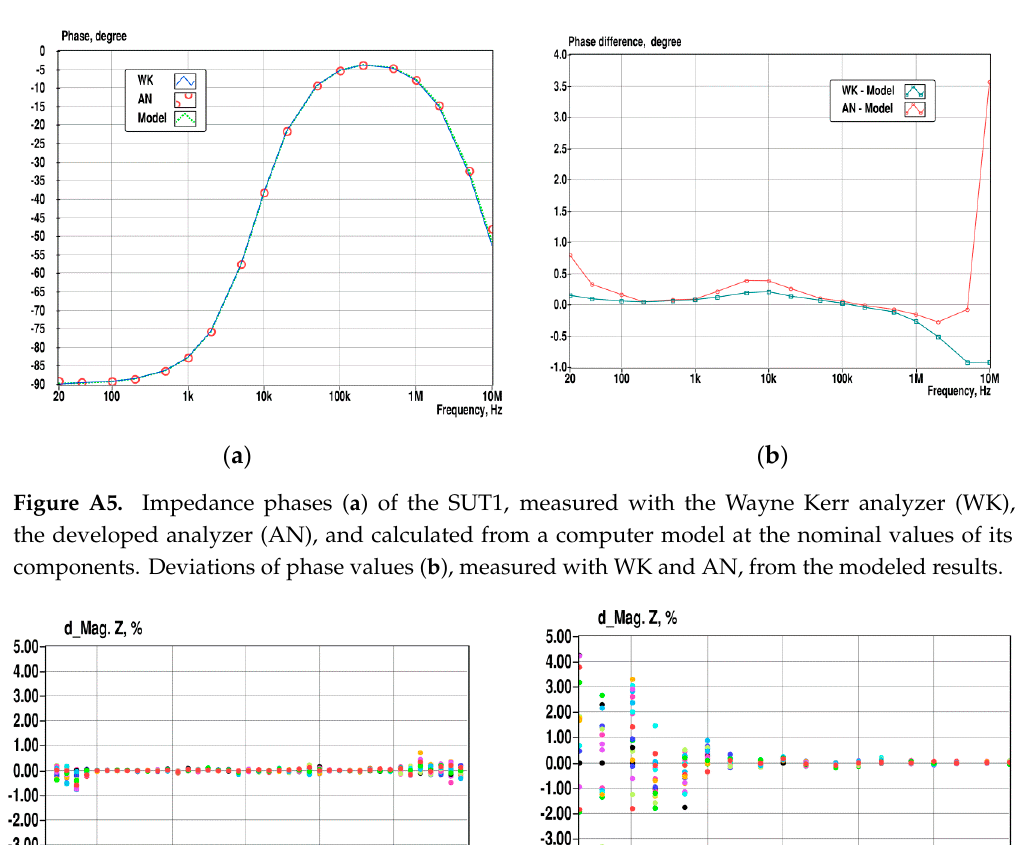
Figure A4. Impedance magnitudes ( a ) of the SUT1 measured with Wayne Kerr analyzer (WK), the developed analyzer (AN), and calculated from the computer model with the nominal values of its components; ( b ) relative deviations of the model’s impedance magnitude from the values measured with WK and AN.